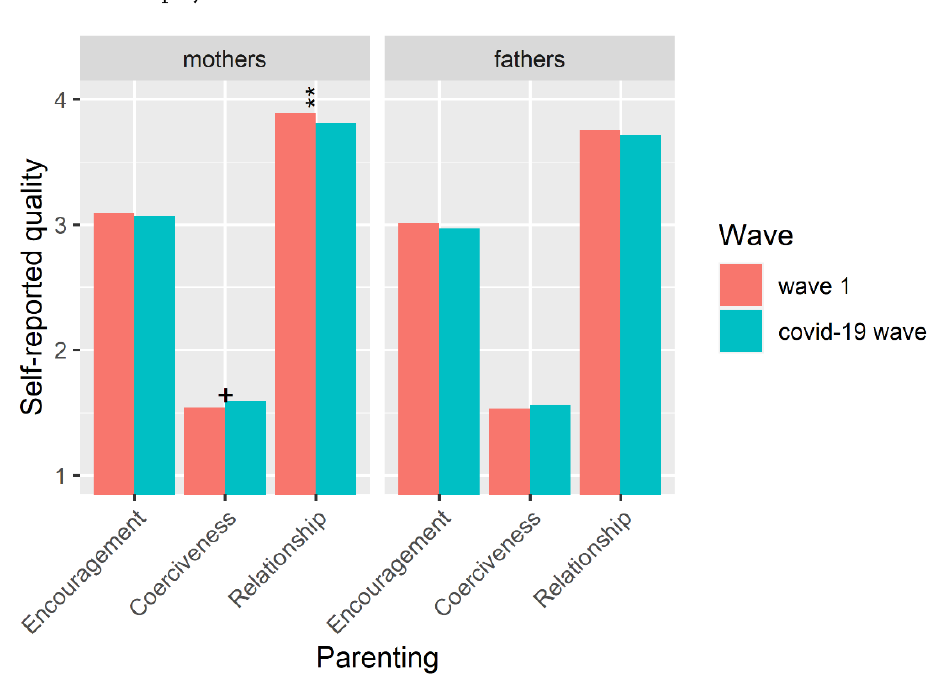
Figure 2 : Self-reported perceived parenting at the two different waves for mothers and fathers. Significance of differences between waves based on paired t-tests are